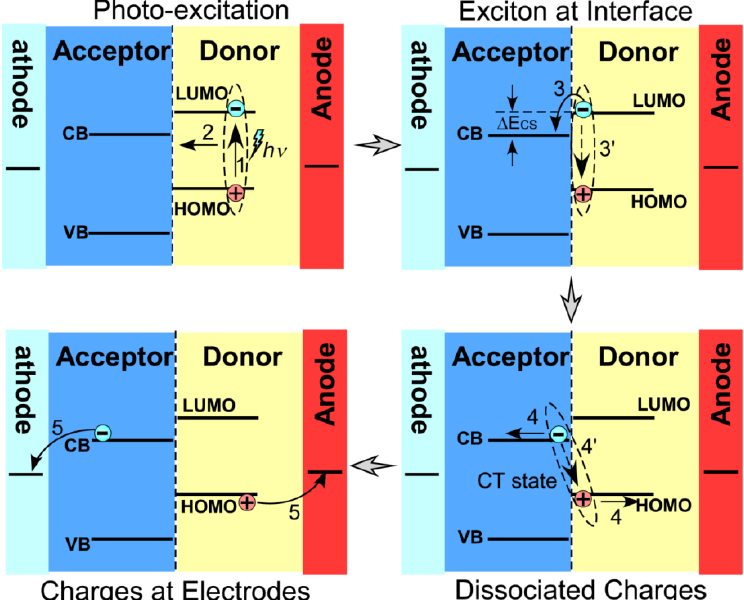
Figure 1. A scheme of the charge separation process at the Donor:Acceptor interface in a hybrid solar cell. The major photovoltaic steps include: photo-excitation into excitons ( 1 ), excitons migration to interfaces ( 2 ), charge transfer from the donor to the acceptor at the interface ( 3 ), charge migration to electrodes ( 4 ) and charge injections into electrodes. There are also competition processes, which can reduce the photovoltaic conversion efficiency, including the recombination of the excitons in the donor and separated charges at the